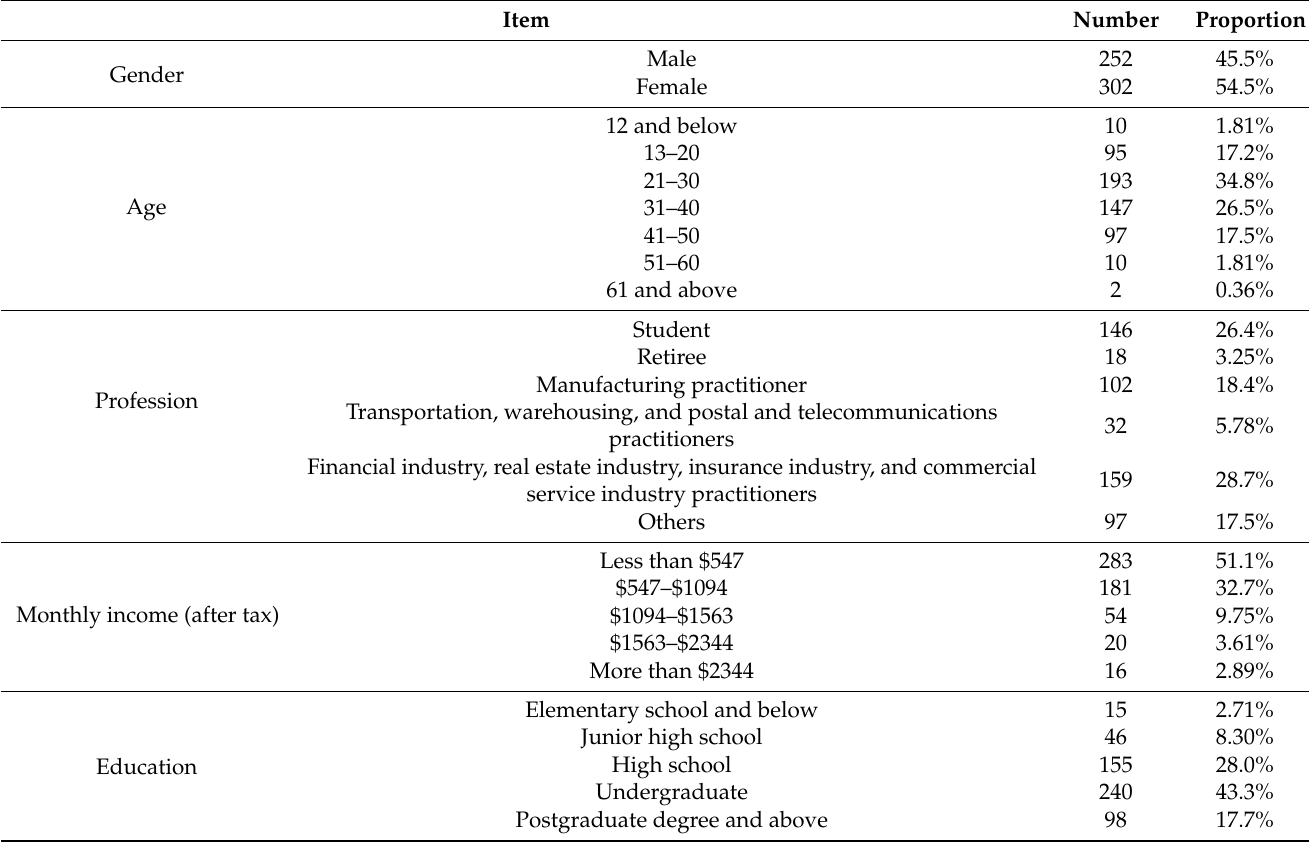
Table 1. Basic information of respondents.